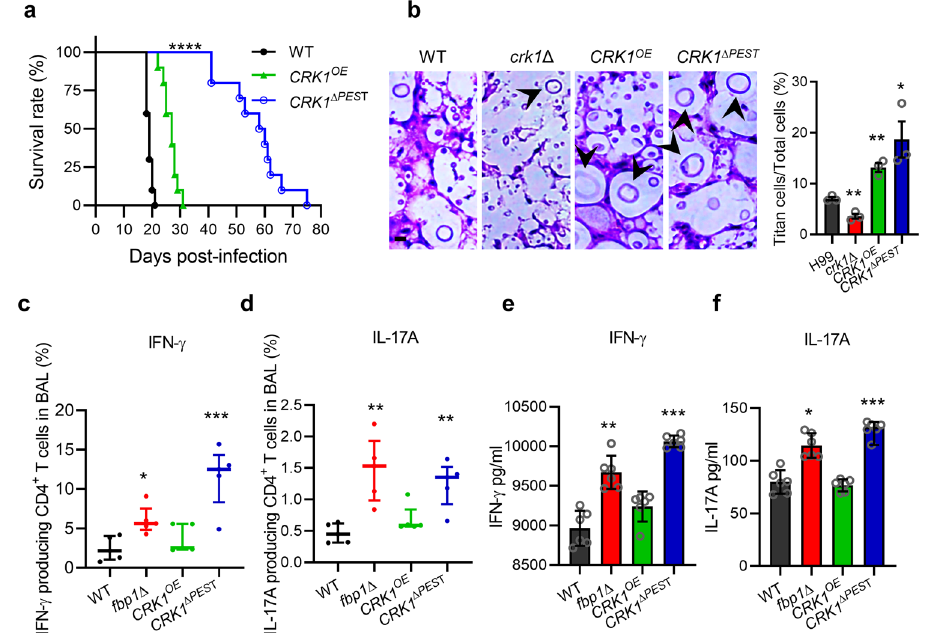
Fig. 5 | Crk1 shapes the host immune response and fungal virulence. a Survival curves for mice after intranasal infection with H99, CRK1 OE , and CRK1 Δ PEST strains, respectively. Statistical analysis was performed based on Log-rank (Mantel-Cox) test. **** P <0.0001. b H&E-stained slides were prepared from cross sections of infected mouse lungs at endpoint and visualized by light microscopy. Bar, 10 µ m. Titan cell percentage was quantitatively measured from infected lung sections at the endpoint. The titan cell percentage data are cumulative from three mice. Error bar indicates 95% con fi dence interval of the median. Statistical analysis was performed with the two-sided Kruskal-Wallis nonparametric test for multiple comparisons.* P =0.03;** P =0.004;0.003. c , d Cytokineexpressionwasanalyzed byintracellularcytokinestaining.PlotsofcytokineproductioninCD4 + Tcellswas gated as Thy1.2 + CD4 + CD8 − T cells. The frequencies of IFN- γ - ( c ) and IL-17A- ( d